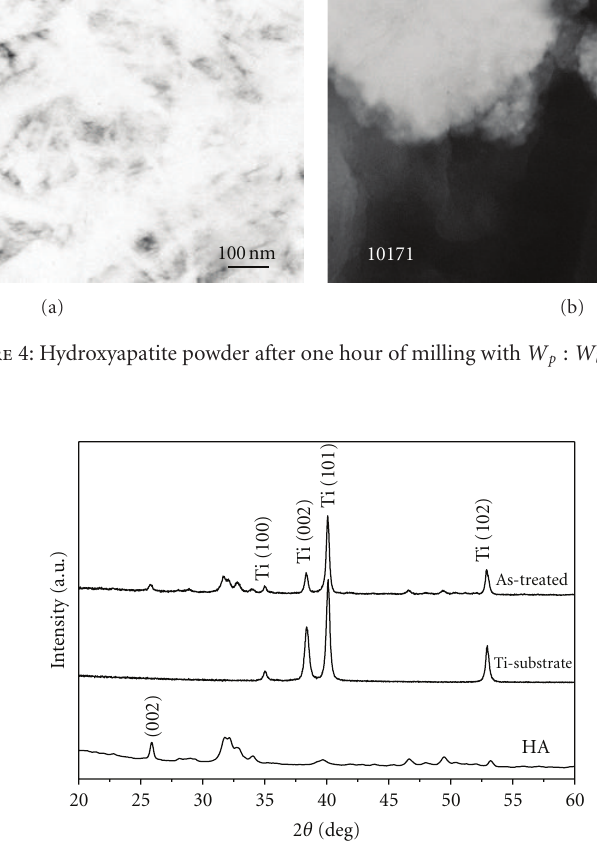
Figure 5: XRD patterns of ball-milled hydroxyapatite-coated Ti substrate after one hour of